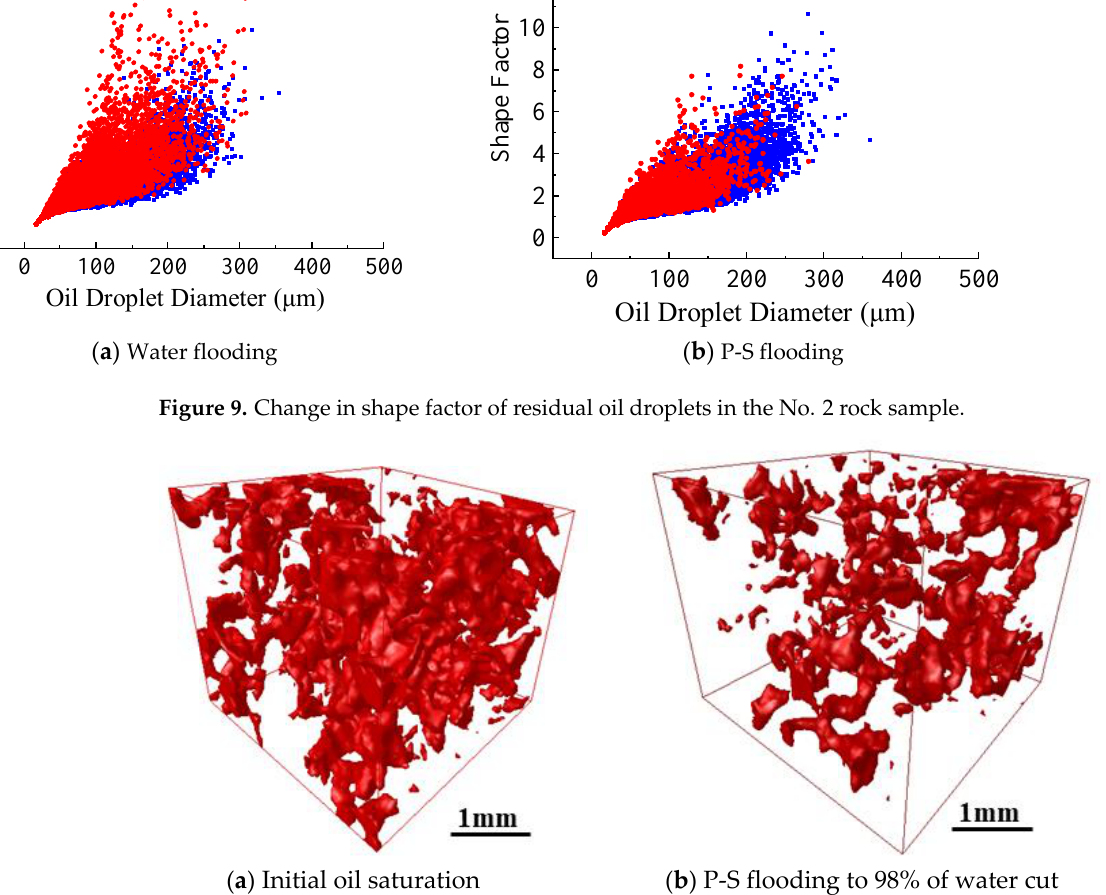
Figure 9. Change in shape factor of residual oil droplets in the No. 2 rock sample.